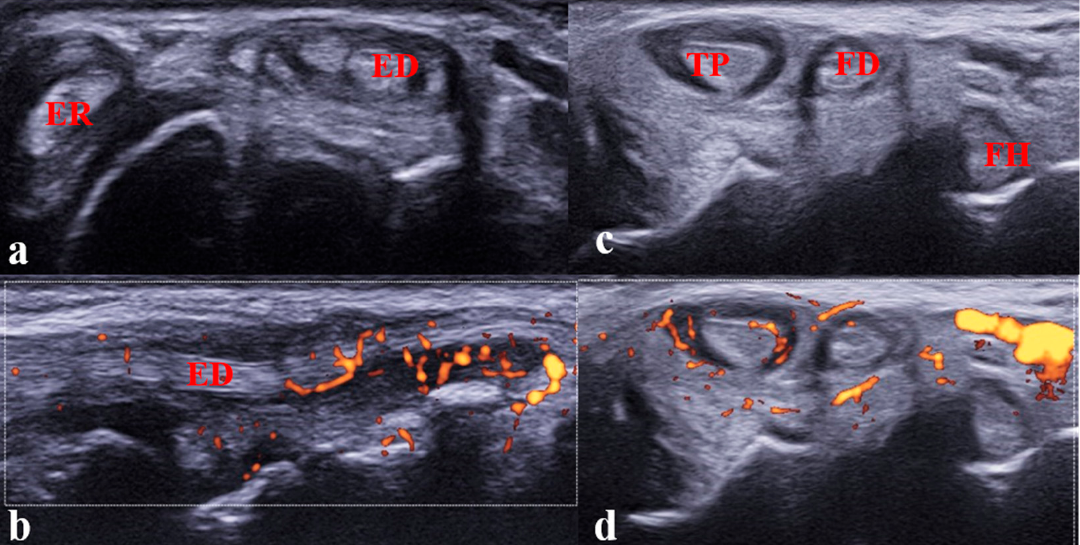
Figure 6. ( a , b ) . Tenosynovitis of the extensor digitorum and extensor carpi radialis tendons in a 12-year-old girl with JIA. ( a ) Transverse scan showing tenosynovitis on B-mode; ( b ) longitudinal scan showing abnormal vascularization on power Doppler mode. Performing the longitudinal scan (B-mode/Doppler mode) is mandatory to confirm the diagnosis of tenosynovitis. ED: extensor digitorum tendon; ER: extensor carpi radialis tendon; ( c , d ). Tenosynovitis of the tibialis poster tendon in an 8-year-old girl with JIA. Transverse scan of the medial compartment showing tenosynovitis.